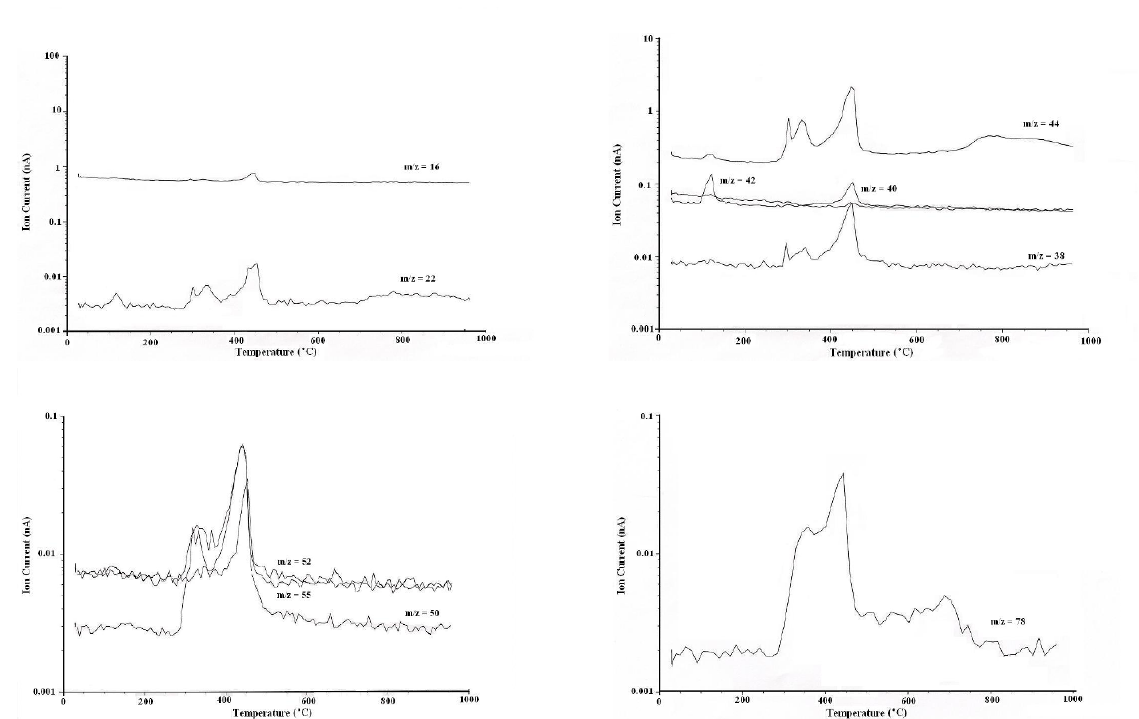
Figure 5. Ion current vs. temperature for Cu